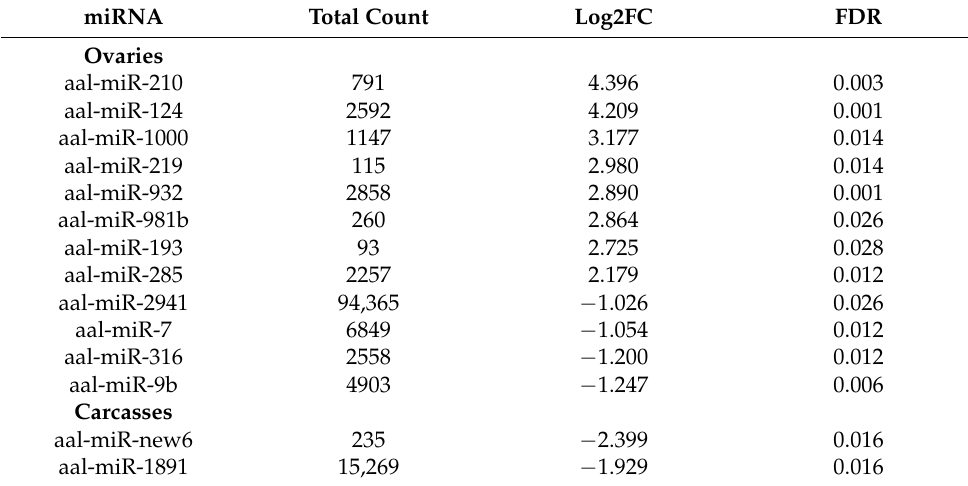
Table 2. Differentially expressed miRNAs in ovaries and carcasses. Total counts are calculated across sequencing libraries of infected replicates. Expression values are expressed as log2 transformed fold-changes